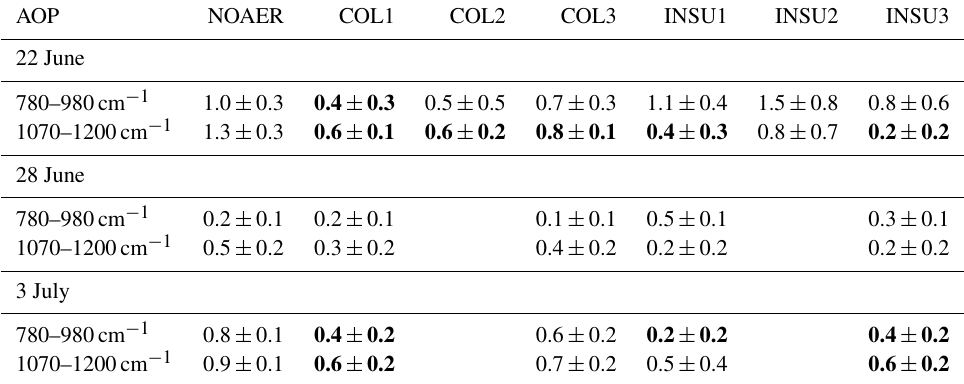
Table 7. Differences (K) between modelled and measured IASI BT spectra in the 780–980 and 1070–1200cm − 1 spectral intervals of the atmospheric window. Model calculations with different AOPs are shown. Differences are expressed as RMSD and standard deviation. Shown in bold are the significant differences with respect to the NOAER simulations.